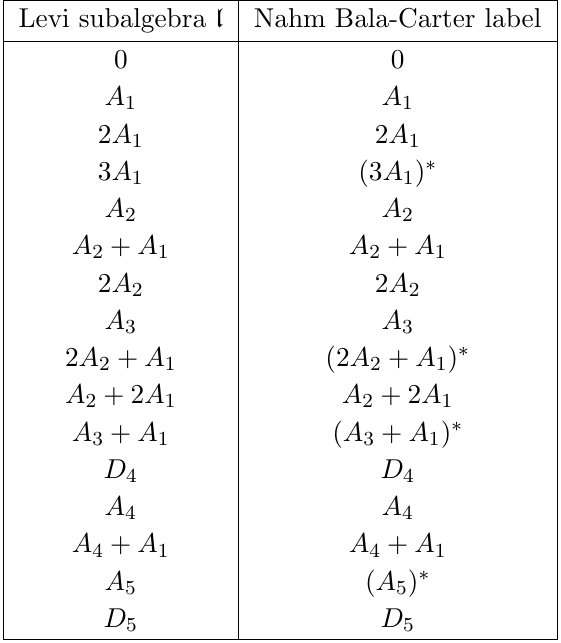
Table 10 . The correspondence between Nahm label and the Levi subalgebra. The Levi subalgebra E 6 is omitted as it does not give any irregular puncture. We use (cid:3) to denote the non-special nilpotent orbit. The pole structure and constraints can be found in [19]. Again, we exclude those with non-principal orbit in the Levi